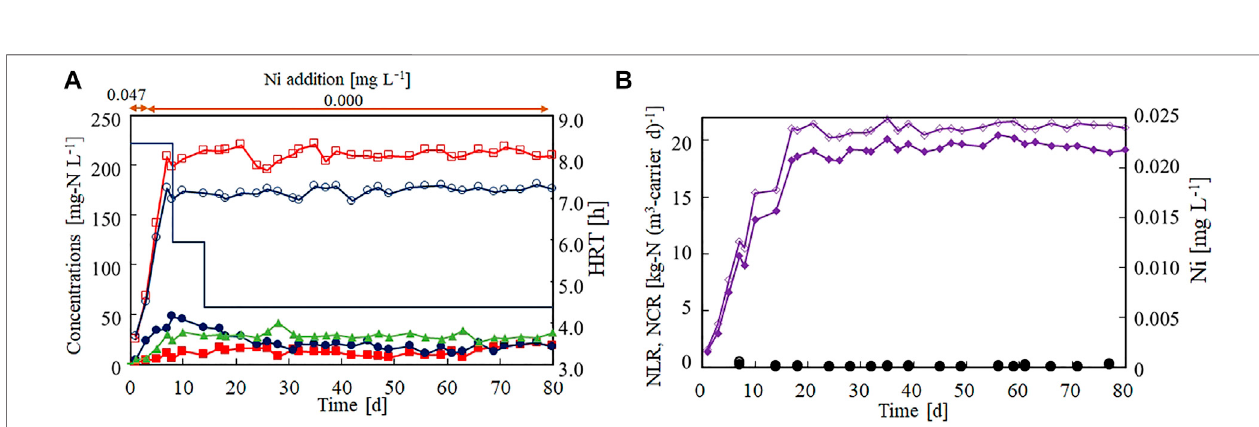
FIGURE 4 | Effect of Ni(II)-limitation on the start-up of the anammox reactor packed with gel carrier. (A) Time courses of in fl uent ammonium (open circles), in fl uent nitrite(opensquares),ef fl uentammonium( fi lledcircles),ef fl uentnitrite( fi lledsquares),andef fl uentnitrate( fi lledtriangles).Thebargraphshowsthehydraulicretentiontime on each day. (B) Time courses of nitrogen loading (open diamonds) and nitrogen conversion rate ( fi lled diamonds). The open and closed circles indicate the in fl uent and ef fl uent Ni concentrations, respectively.